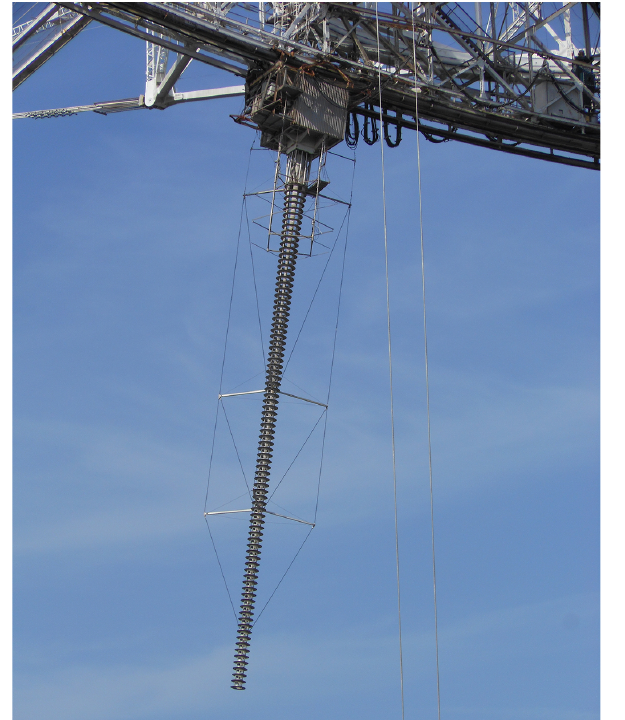
Figure 9. The modern 430MHz linefeed and coaxial 46.8MHz dual-polarization Yagi feeds as of August 2012. The 46.8MHz feed is comprised of four, 3-element Yagi antennas and yields ∼ 1.4 ◦ full- width at half-maximum beamwidth and ∼ 40dBi gain (Mathews et al., 2010). Photo by